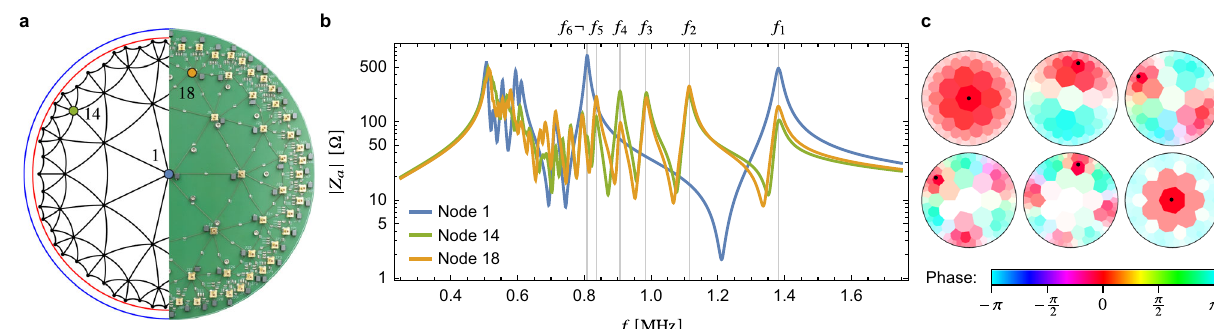
Fig. 3 | Experimental data. a Schematic of hyperbolic tessellation (left half) with the unit circleinblue and the circle with radius r 0 =0.94 in red,and photographof the electric circuit (right half). b Measurement of impedance to ground Z a of the circuit at node a as a function of input frequency f for different nodes (see inset legend and panel a for an identi fi cation of the nodes). Each impedance peak indi- cates an eigenmode at that corresponding frequency, which can be excited at the